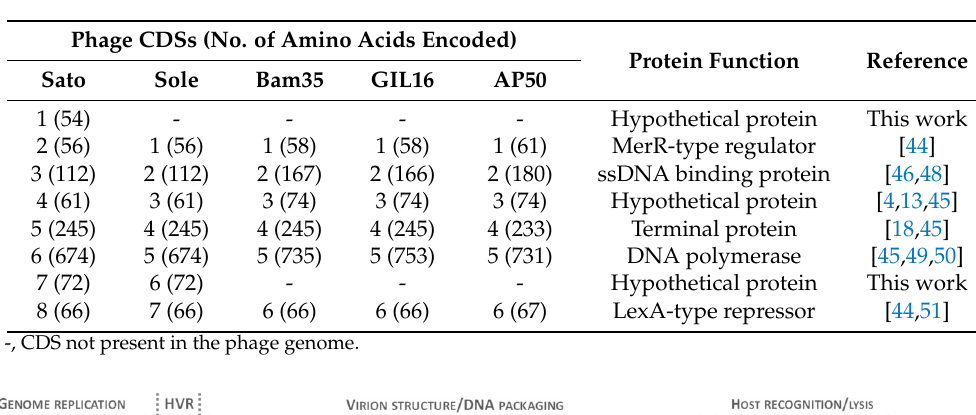
Table 2. Percentage of amino acid sequence identities of common proteins encoded in the gene reg- ulation-genome replication module of Sato and Sole and other betatectiviruses 1 .